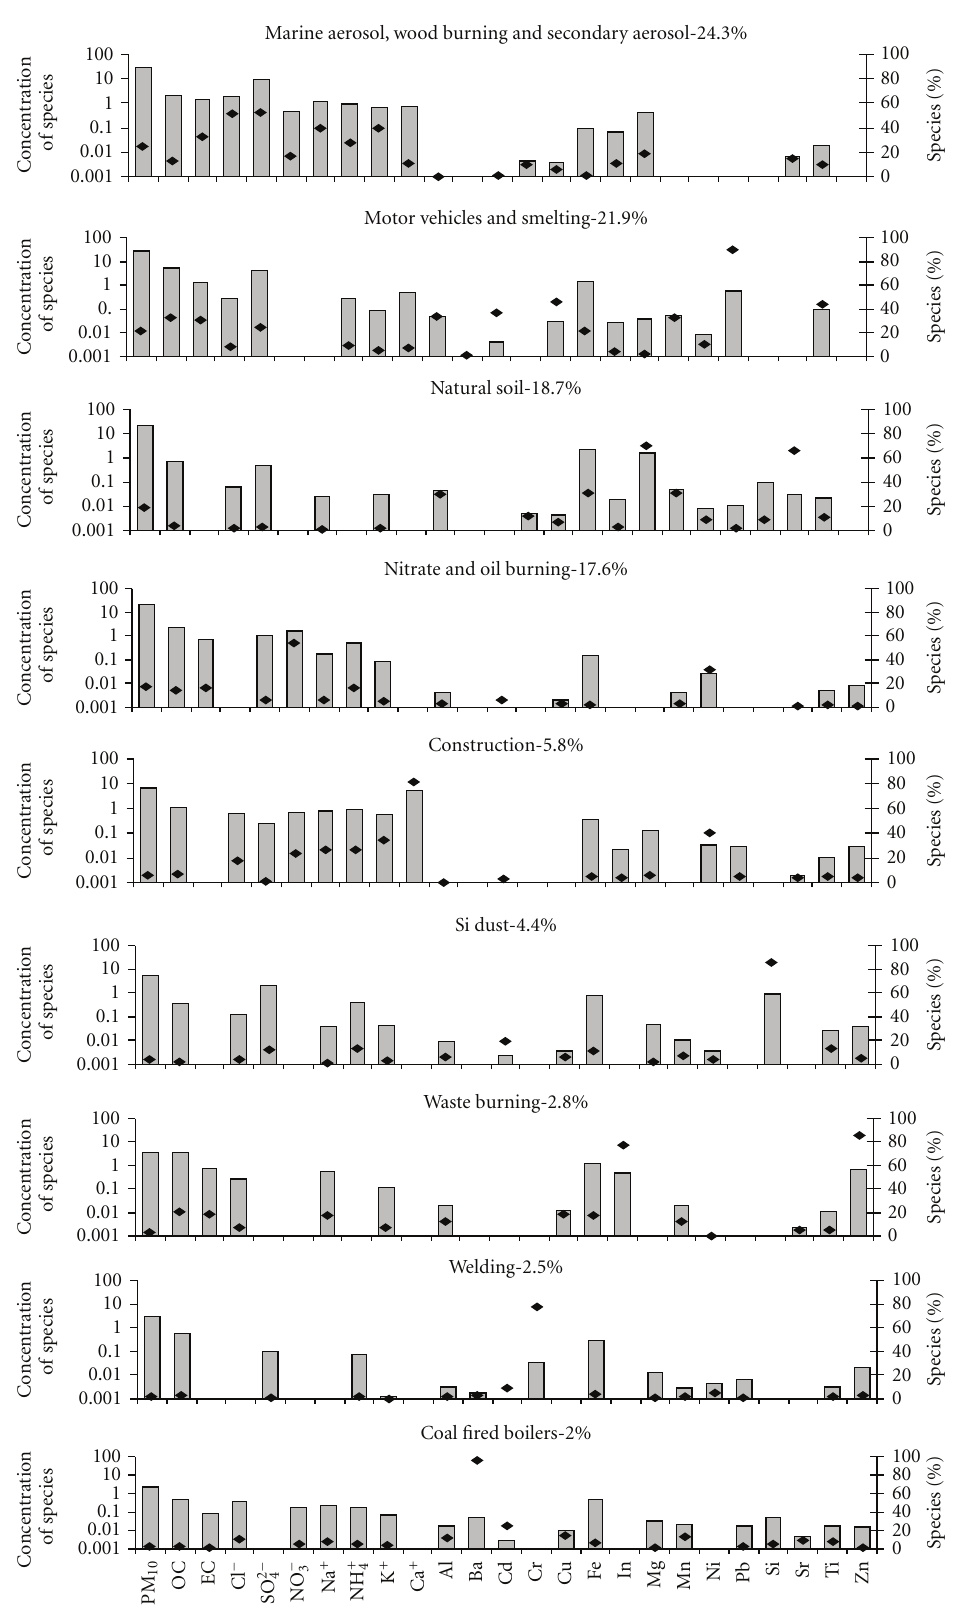
Figure 7: PMF factor profile for